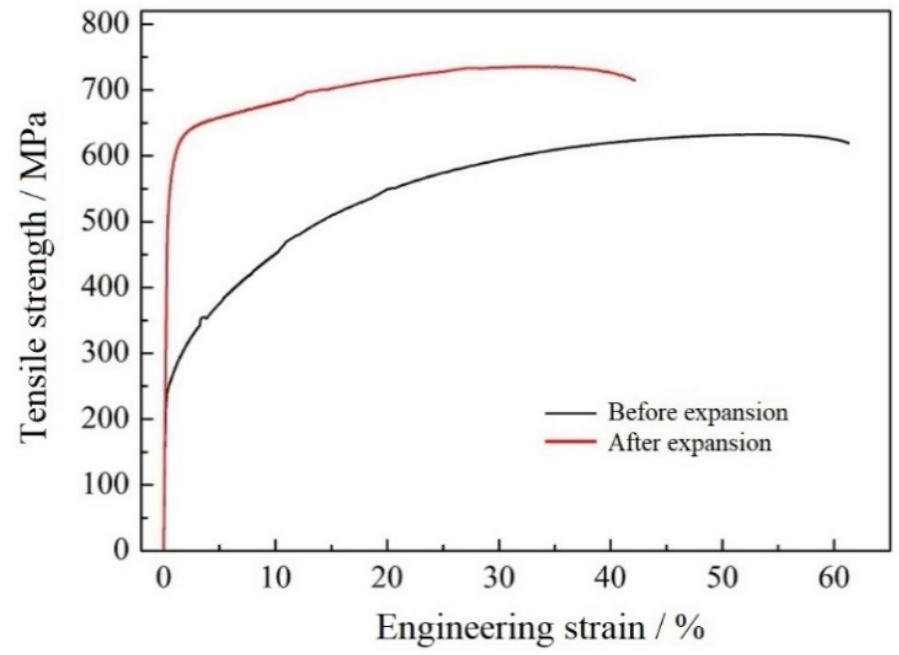
6 of 12 Figure 3. TEM images of AISI 304 SS before and after expansion: ( a , b ) before expansion; ( c , d ) after expansion. The stress–strain curves obtained from the tensile test of AISI 304 SS before and after